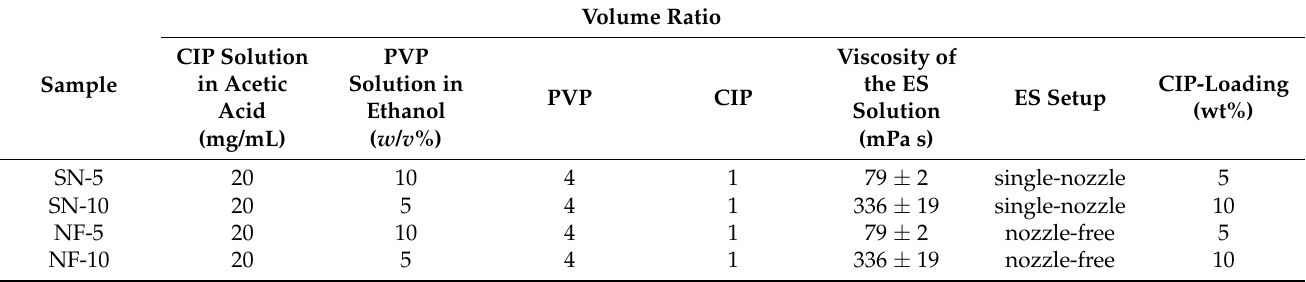
Table 2. The composition and preparation procedures of each sample. Abbreviations: CIP—ciprofloxacin, PVP—polyvinylpyrrolidone,